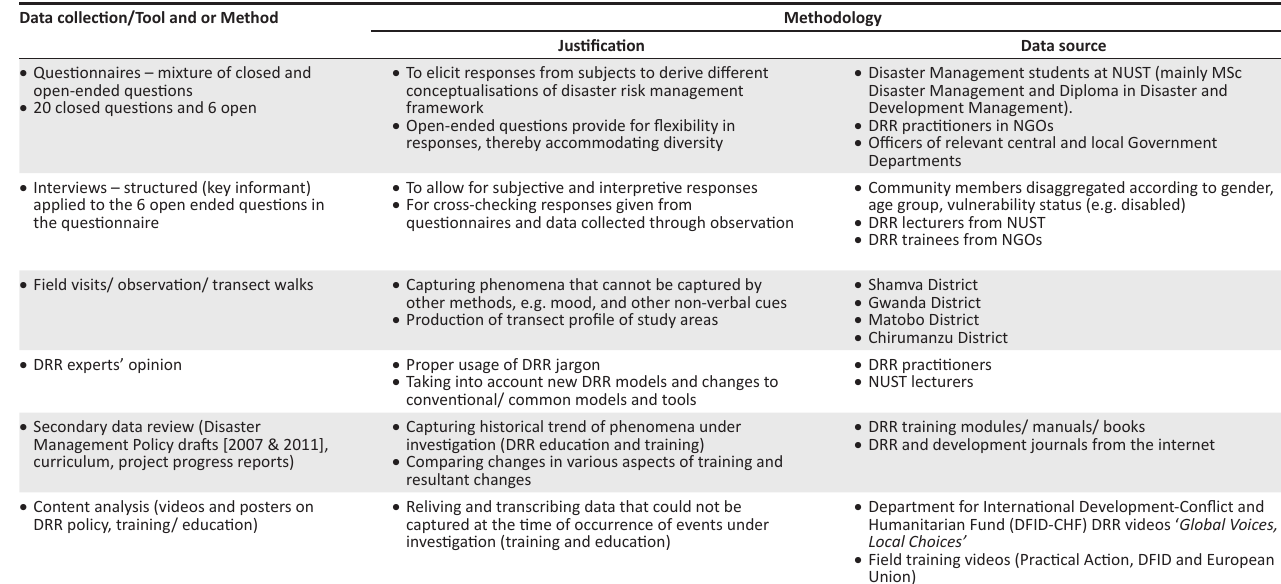
TABLE 1: Research methodology